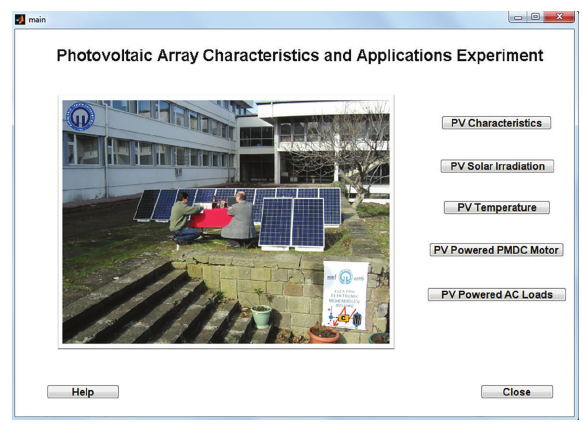
Figure 1: The main menu of